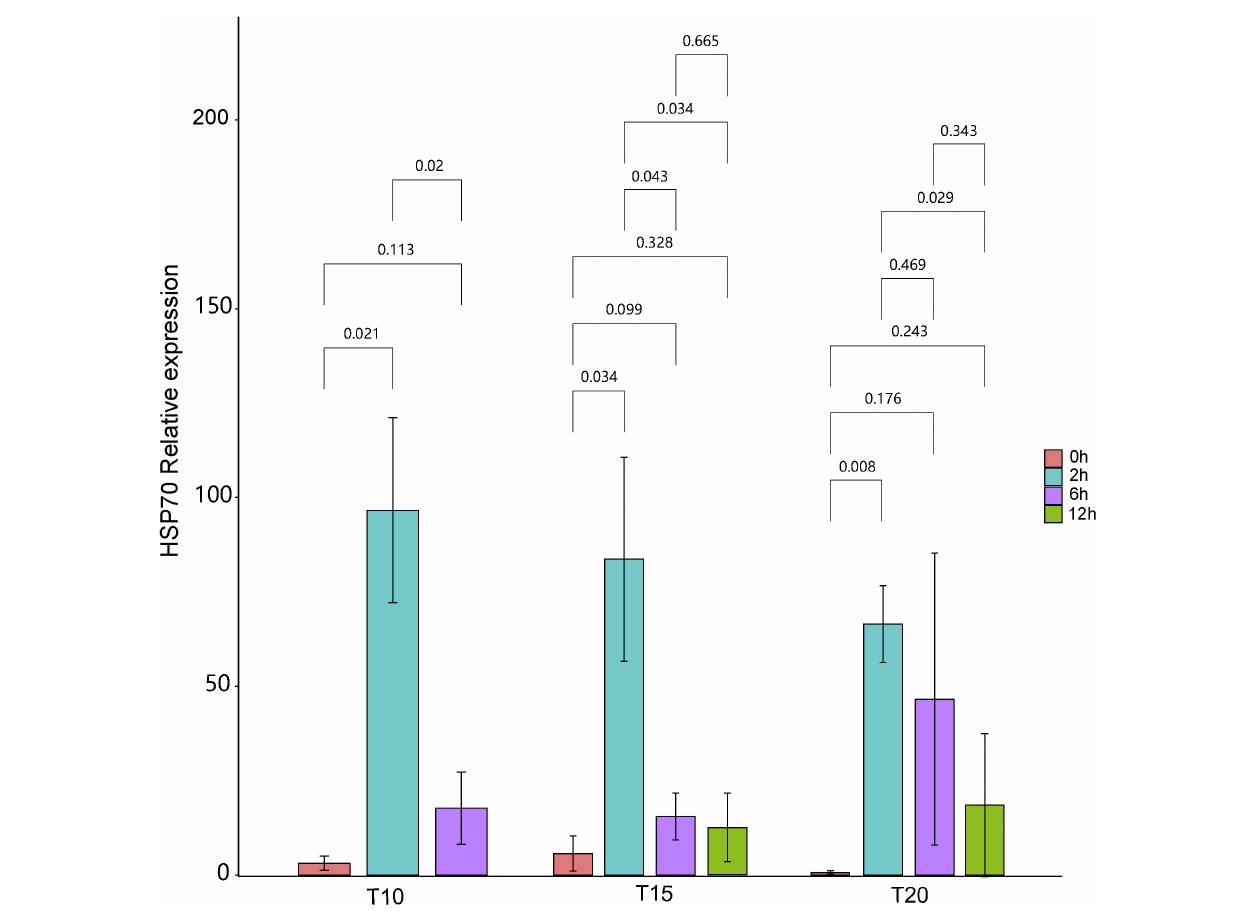
FIGURE 1 | The relative expression of intestinal HSP70 of heat stressed O. stewarti juveniles with different acclimation histories. T10, T15, and T20 indicate 10 ° C, 15 ° C, and 20 ° C acclimation temperature backgrounds of the experimental fish. The values 0–12 h represent the duration of the heat stress.